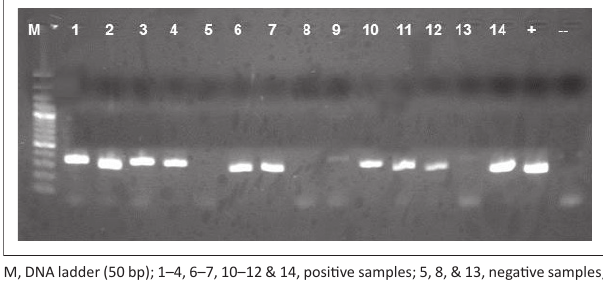
FIGURE 2: Gel electrophoresis of Coxiella burnetii polymerase chain reaction. Amplified polymerase chain reaction product with amplicon size of 257 bp.